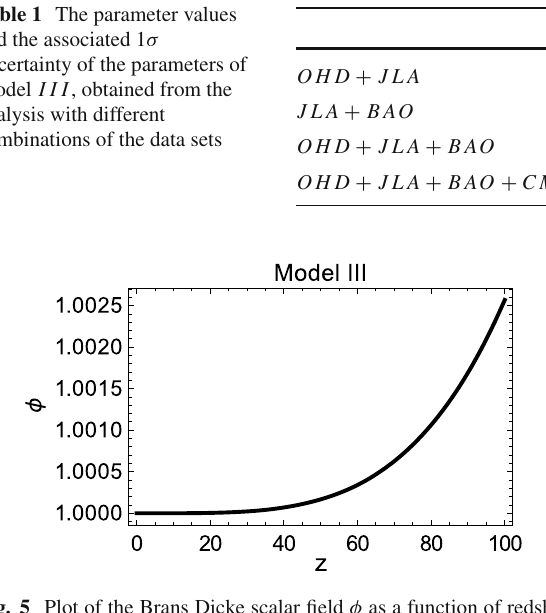
Fig. 5 Plot of the Brans Dicke scalar field φ as a function of redshift for Model I I I , scaled with φ